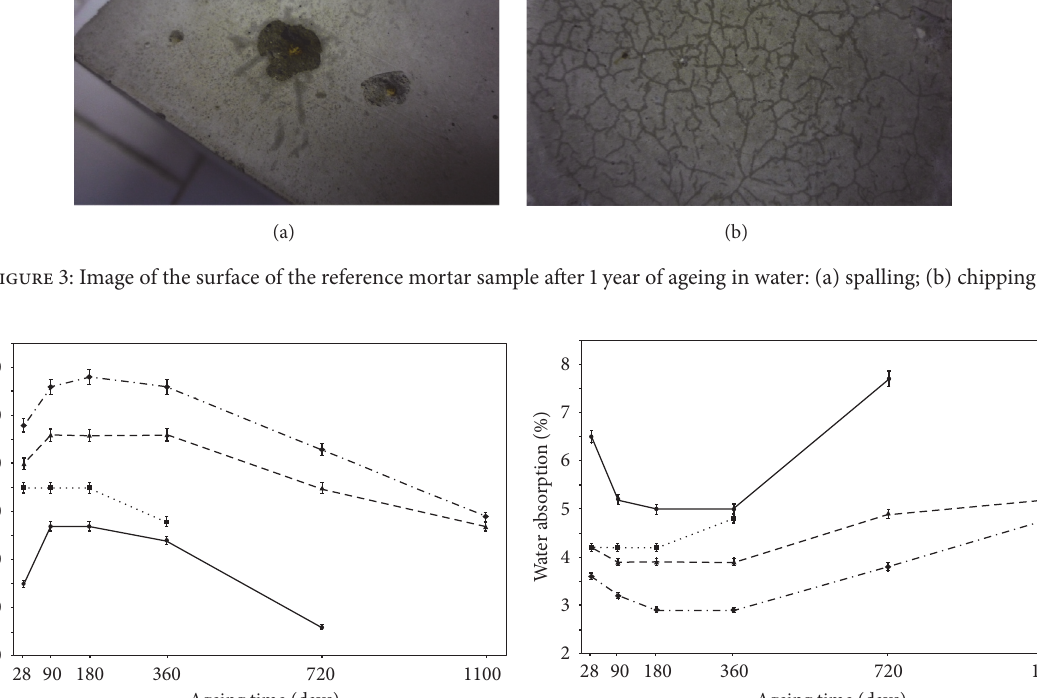
almost constant from 180 to 360 d but grows for longer ageing times reaching the values of 3.8 and 4.8 after 720 and 1100 d,